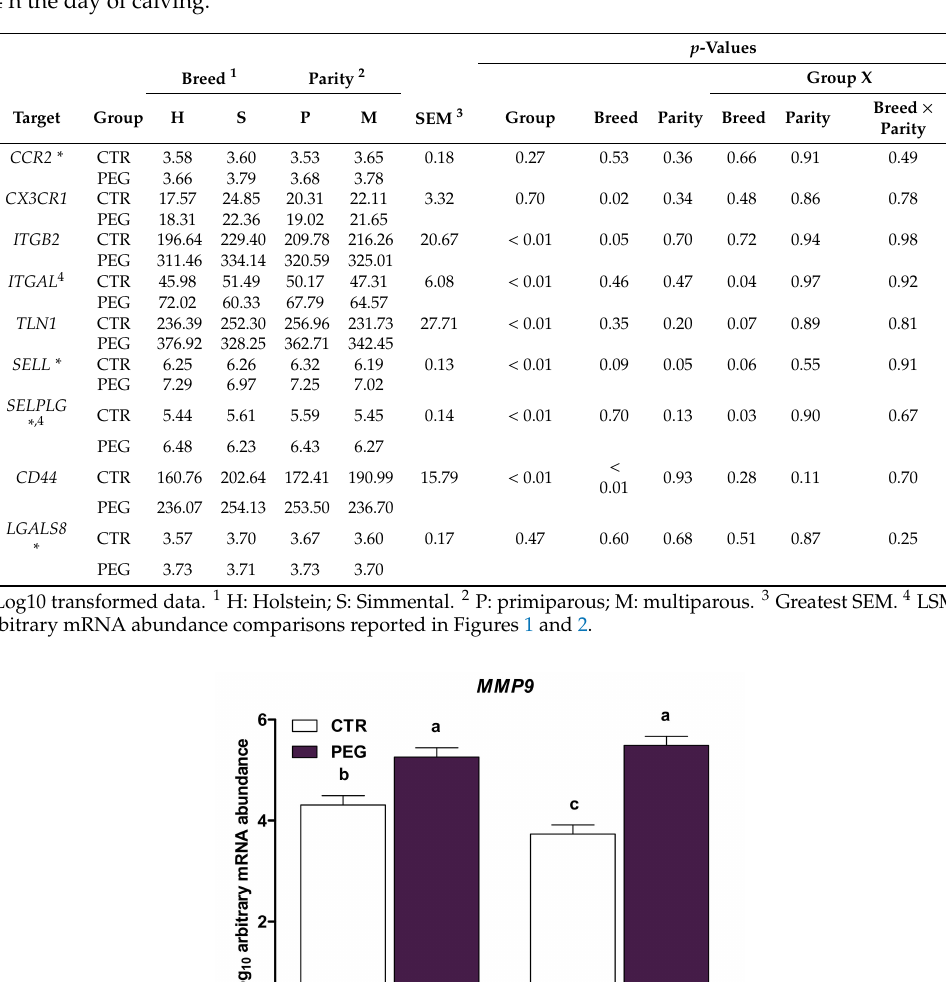
Table 2. LSM of arbitrary mRNA abundance for genes related to migration and cell adhesion functions in whole blood leukocytes evaluated 3 days after calving from Simmental and Holstein cows treated with pegbovigrastim (PEG) or with saline (CTR) at approximately Day 7 relative to calving and within 24 h the day of calving.